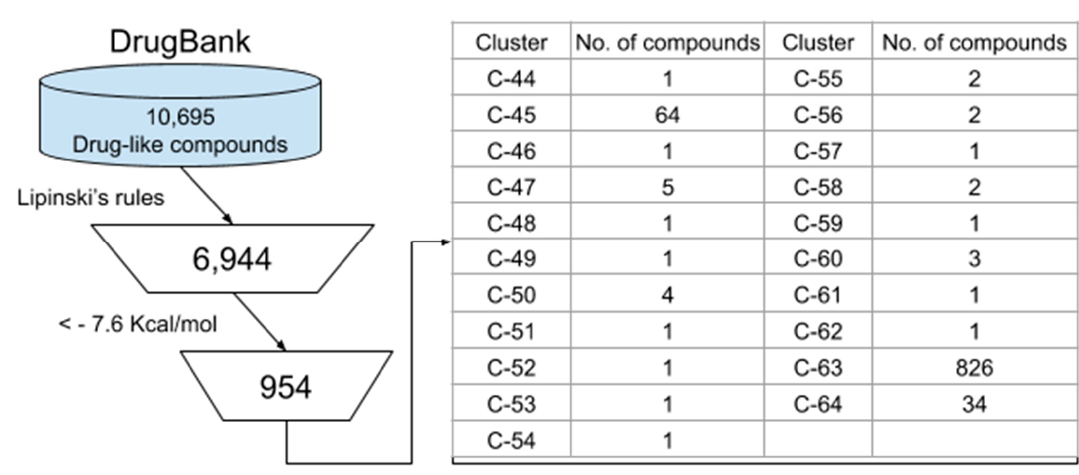
Figure 5. Virtual screening of compounds from DrugBank. Selected compounds were classified into 21 clusters based on MACCS fingerprint similarity.